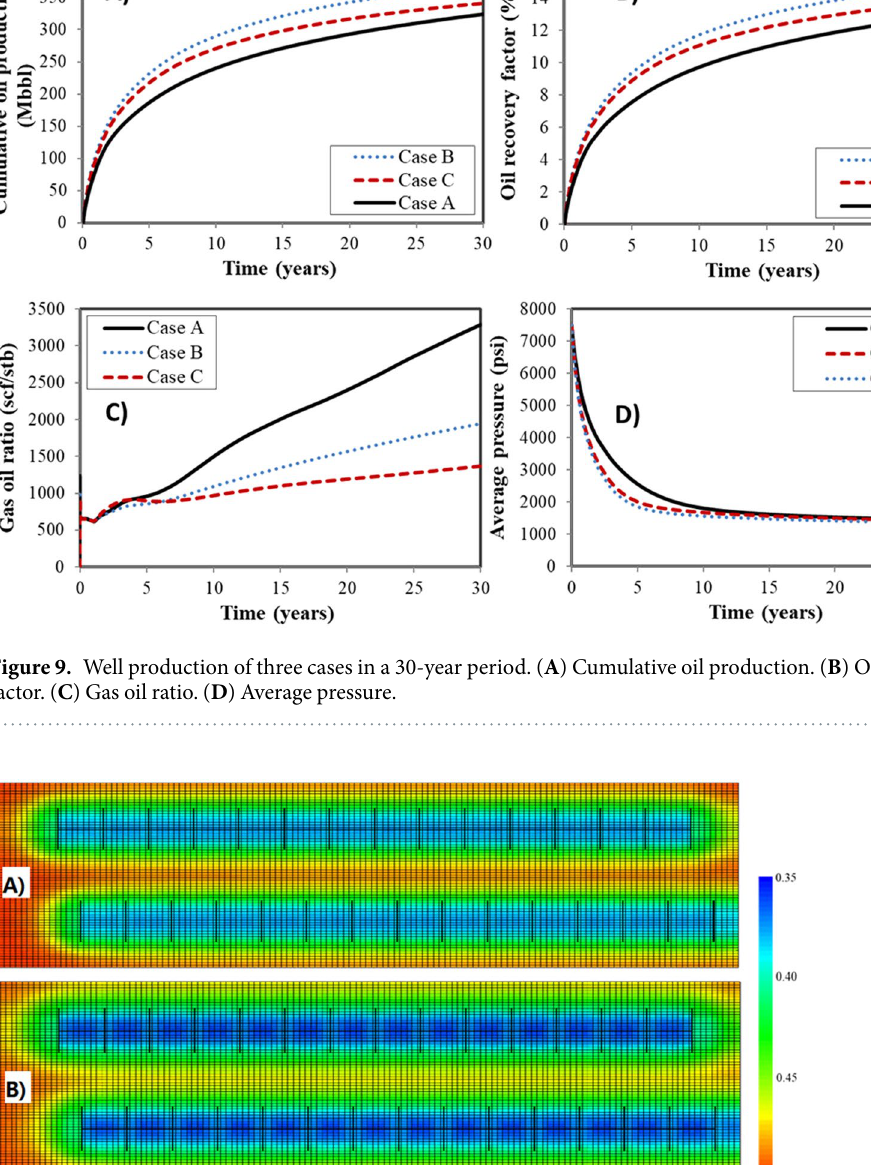
The results in Case C indicate that the deformation decreases rock permeability and negatively influences the fluid flow capacity. The stress-dependent deformation affects the connections, leading to the resistance during the fluid flow process. However, it should be noted that with the consideration of rock deformation, pore size reduces, resulting in more suppression of the bubble point pressure for the confined fluid during the oil production. The two-phase flow delays with light components dissolved in it, and the flow capacity increases. Hence, it would